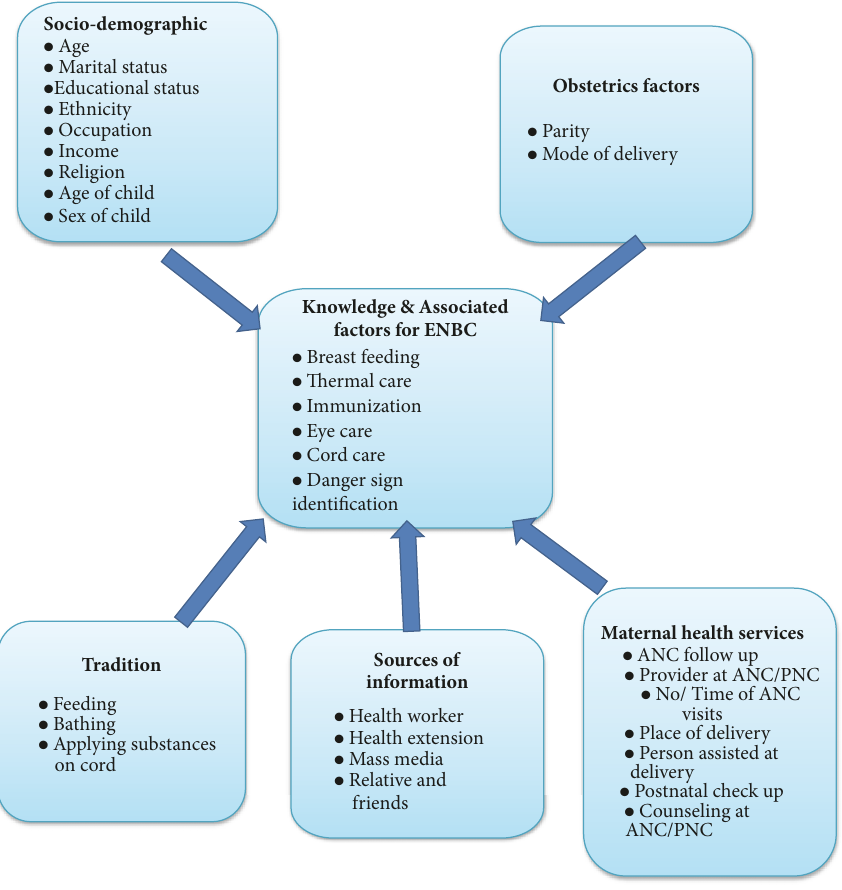
Figure 1: Conceptual frame work for factors that affects essential newborn care (adopted from Journal of perinatology 2002; 22:572–576).